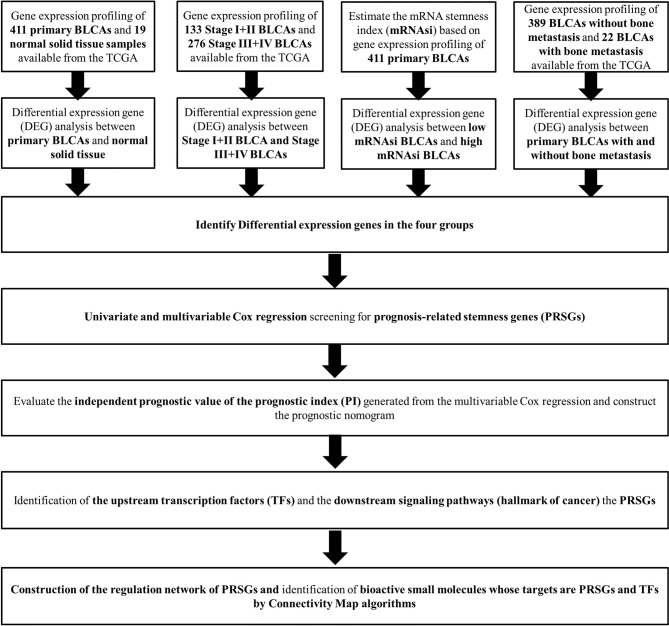
The flowchart of all analysis processes.